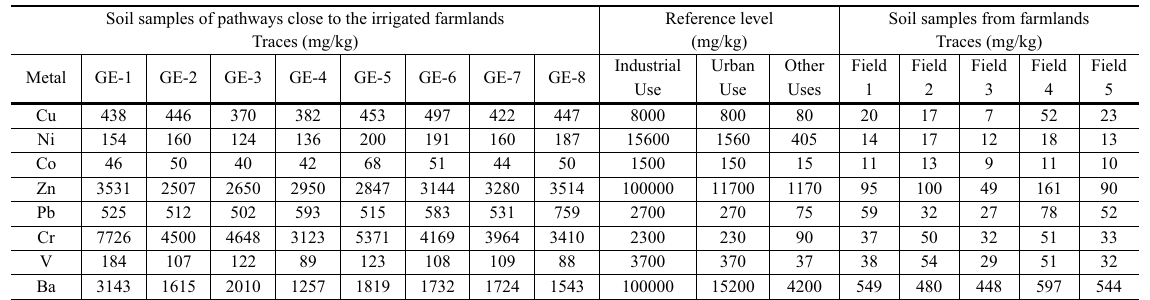
Comparison between the reference levels of heavy metals for the protection of human health in Madrid (Comunidad de Madrid 2006) and the concentration of heavy metals in different soil